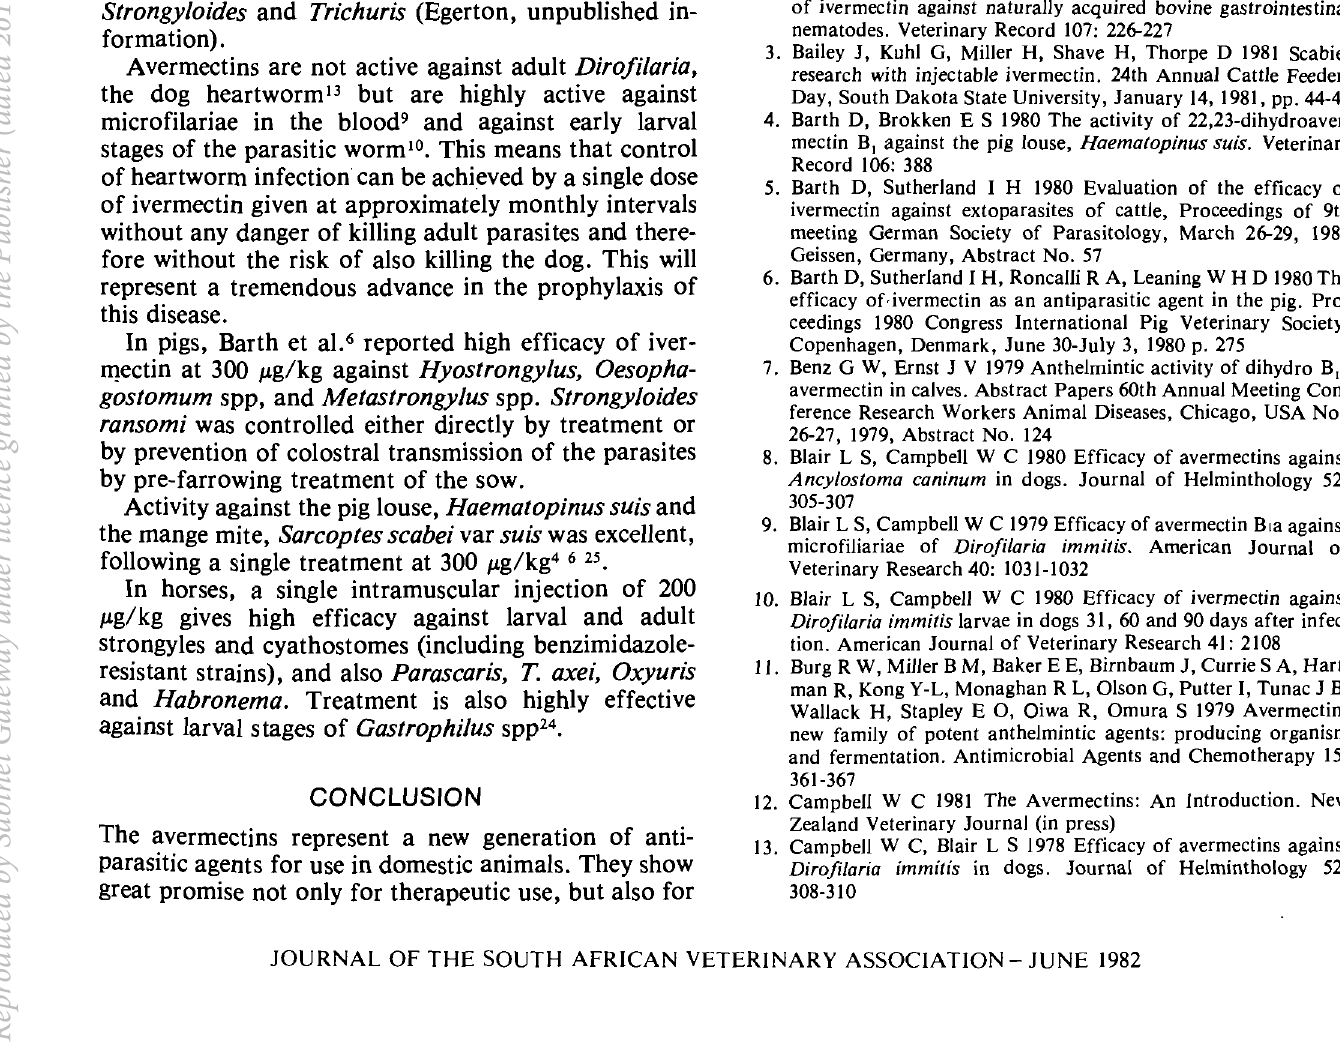
TABLE 3: A SUMMARY OF TRIALS DEMONSTRATING EFFICACY OF IVERMECTIN IN CA TILE AT 200 ,ug/kg AGAINST . OSTERTAGIA OSTERTAG!* Number Number of Animals Range of Mean of Parasites . Efficacy Control Treated in Controls Trials Adult 23 154 145 137·42050 >99 Developing L4 14 88 85 313·48316 98 Inhibited L4 *From Leaning W.H.D. 1981 24 TABLE 4: ARITHMETIC MEAN NUMBERS OF SARCOPTES BOVIS FROM CATILE TREATED WITH IVERMECTIN* (TOTAL NUMBER OF LIVE MITES FROM 7 SITES) Number Day of observation (Treated Day 0) Group of Animals -1 7 Control 3 504 551 100 .ug/kg s.c. 3 457 105 0 200.ug/kg s.c. 467